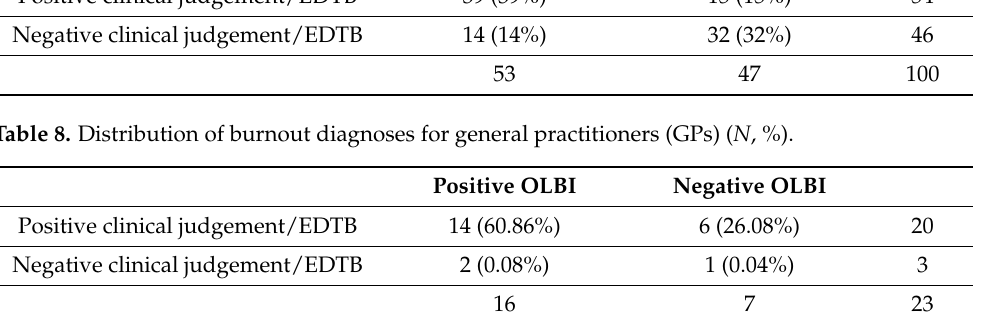
Table 7. Distribution of burnout diagnoses for occupational physicians (OPs) ( N , %). Positive OLBI